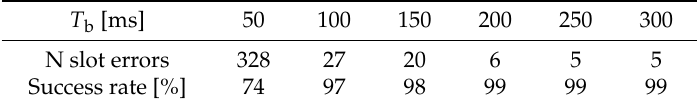
Table 4. The number of slots failed respect to tolerance interval shrinkage.